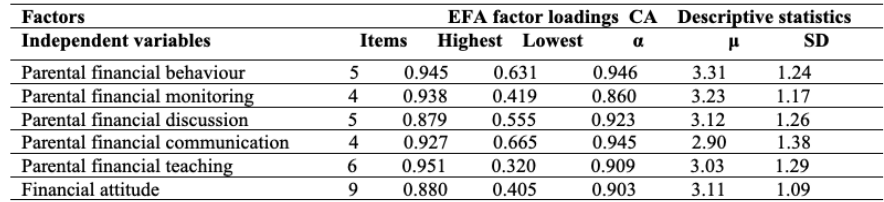
Table 2: Validity, reliability and descriptive statistics results